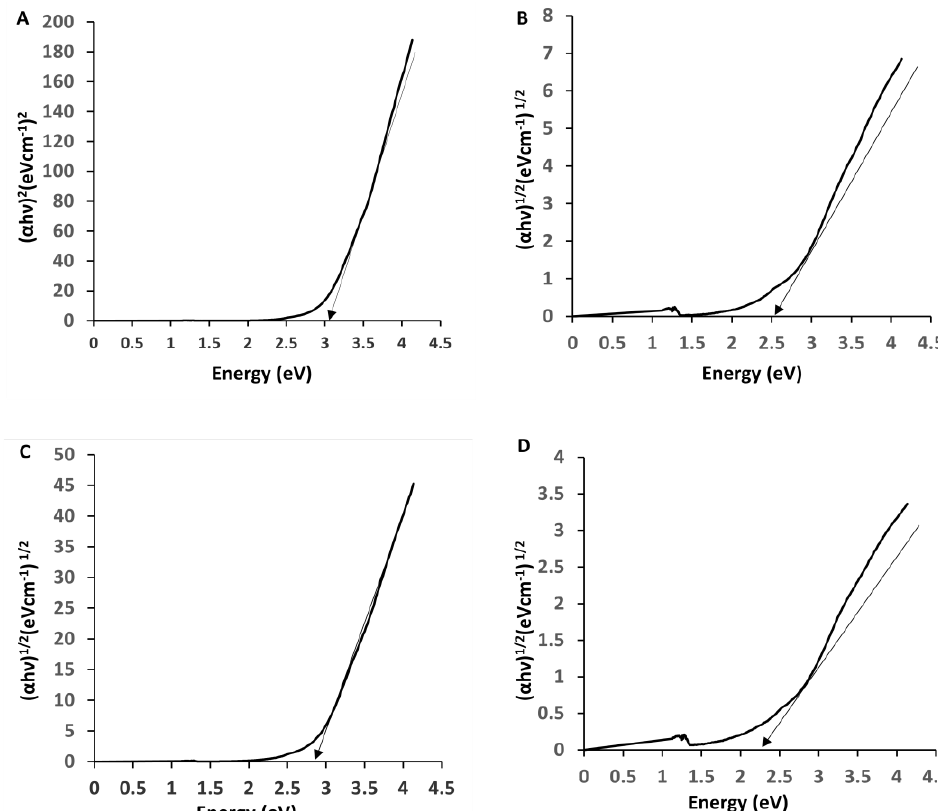
Figure 5. Band gap energy for CF-MNPs (direct ( A ), indirect ( B )) and for ZCF-MNPs (direct ( C ), indirect ( D )).